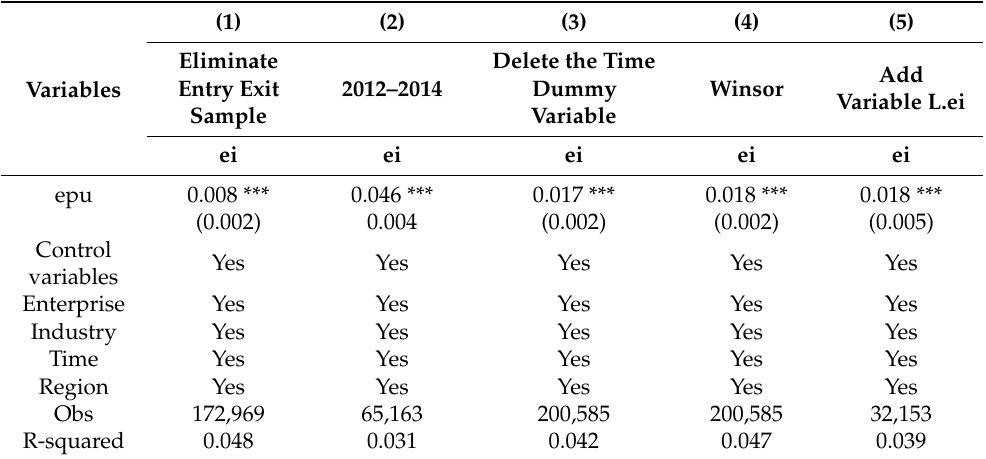
Table 9. Regression results of eliminate the entry and exit samples, adjust the sample period and